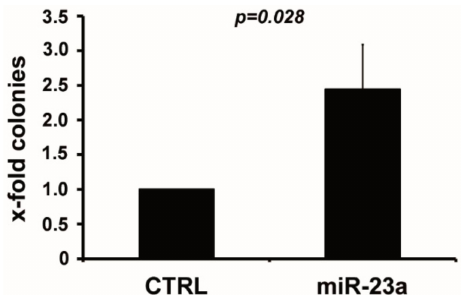
Figure 2. Clonogenic assays after miR-23a overexpression and cytarabine-treatment. For soft agar colony formation assays, U937 cells carrying a miR-23a overexpression construct (miR-23a) and empty vector control (CTRL), respectively, were incubated with 5 µ M cytarabine for 2 h. Subsequently, 7500 cells were seeded in 4 mL soft agar and colonies were counted after 8–10 days. The graphs summarize the results of at least three independent experiments. Data are expressed as mean ± SD, and the p -value has been calculated using Student’s t